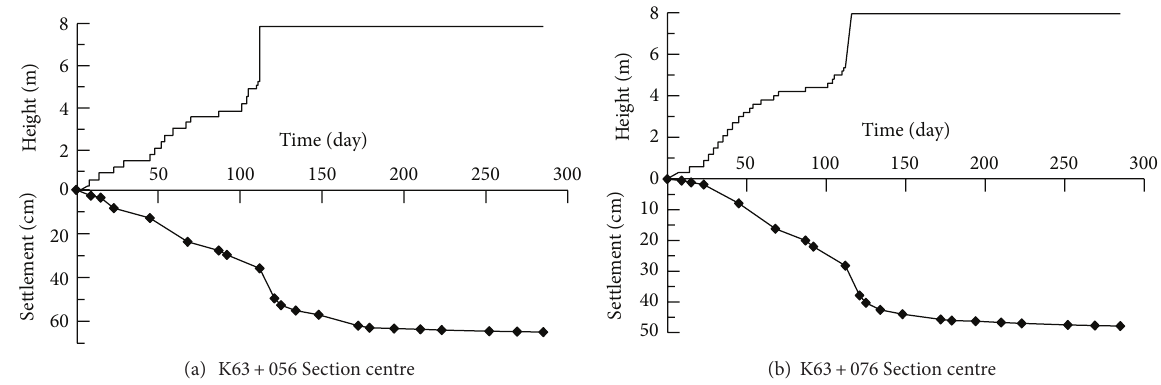
Figure 14: Settlement of soil